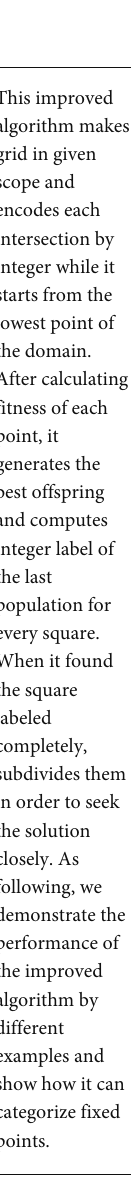
Figure 1: Improvement genetic algorithm fl ow